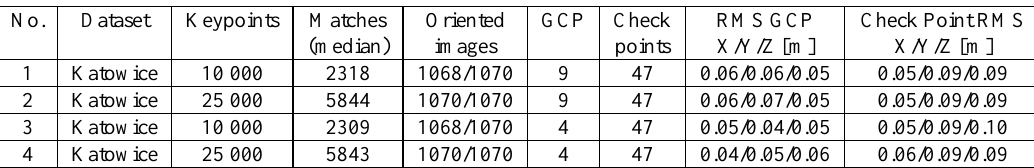
Table 5. The results for GCP number and distribution analysis in